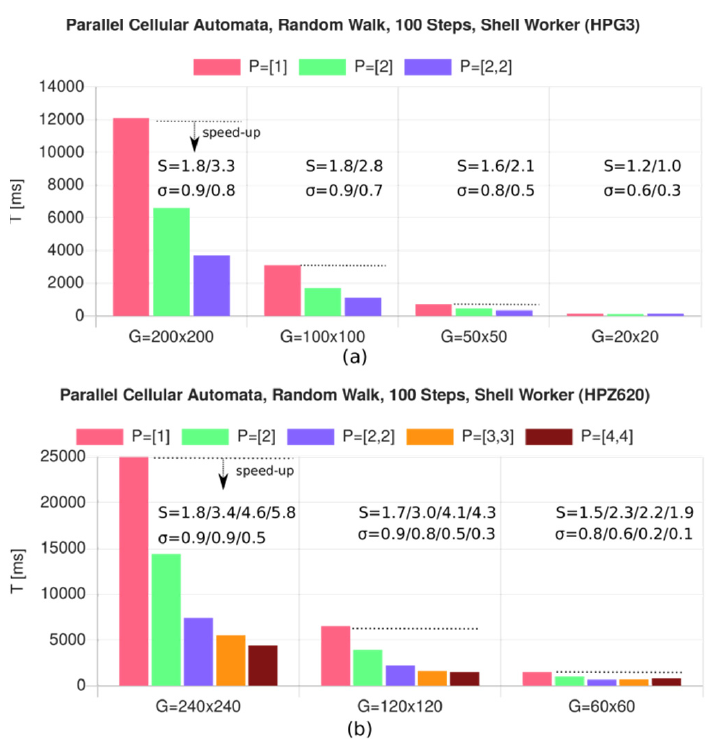
Figure 10. Parallel simulation results using shell worker processes, showing the total simulation time for 100 simulation steps in dependency of the parallel partitions (rows, cols), S: speeding up, σ : scaling up, ( a ) HP-G3 mini ( b ) HP-Z620 workstation.